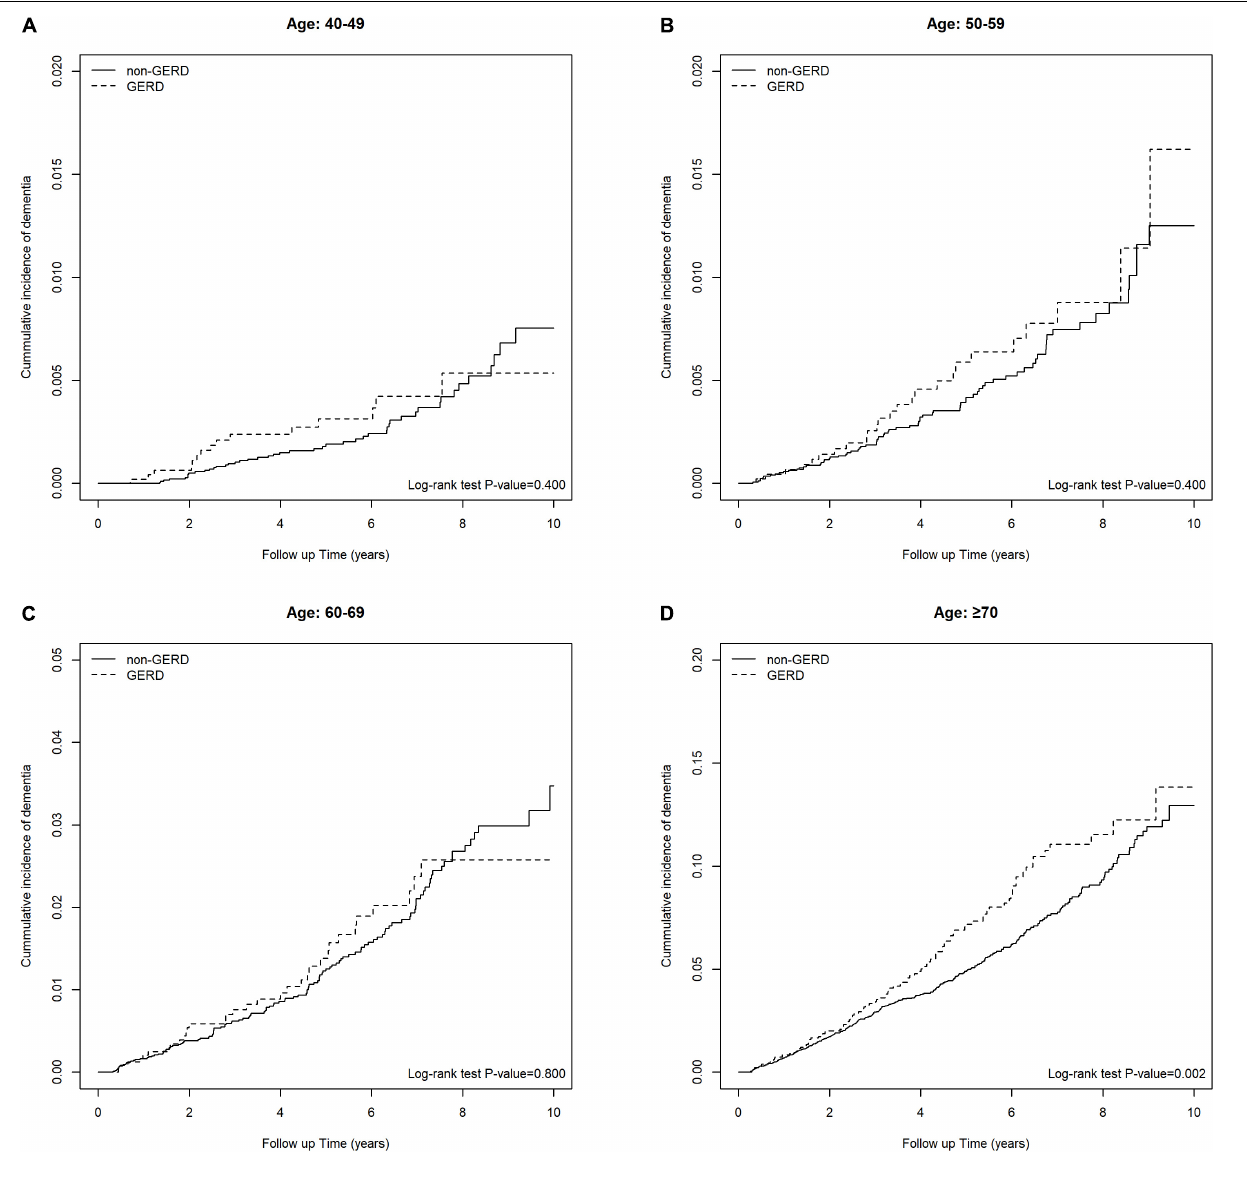
FIGURE 3 | (A) Keplan Meier plot of the cumulative incidence of developing future dementia in people between 40–49 years old. (B) Keplan Meier plot of the cumulative incidence of developing future dementia in people between 50–59 years old. (C) Keplan Meier plot of the cumulative incidence of developing future dementia in people between 60–69 years old. (D) Keplan Meier plot of the cumulative incidence of developing future dementia in people > 70 years